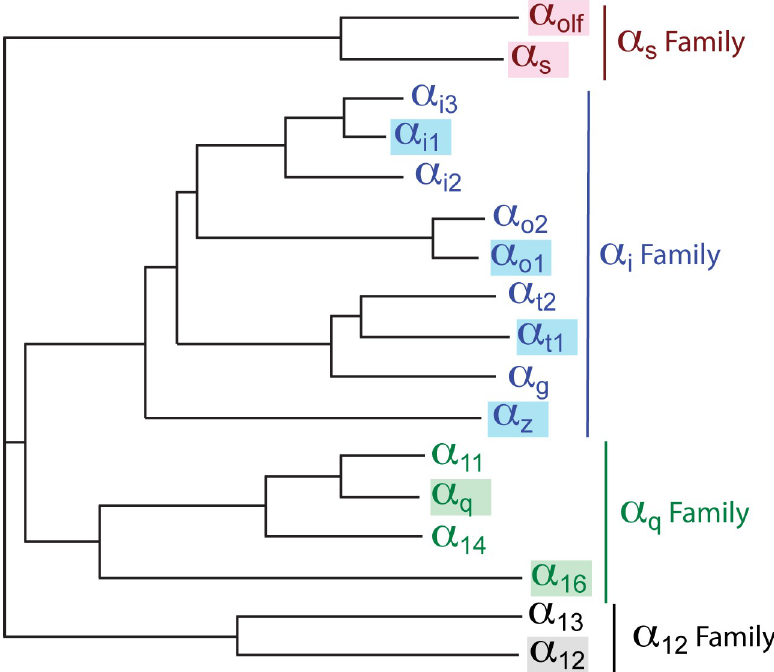
Fig 1. Phylogenetic relationship of human G α subunits. All the G α subunitsthat have beenhighlightedin the family-specific colourswere attempted to be converted into mini-G proteins.The phylogenetic relationships